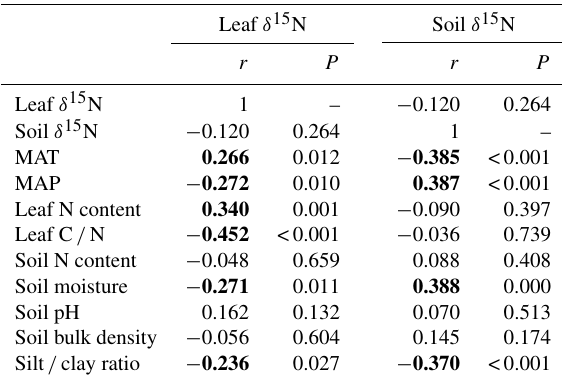
Table 3. Correlation analyses between leaf or soil δ 15 N and influ- ential factors on the north slope of Tian Shan.